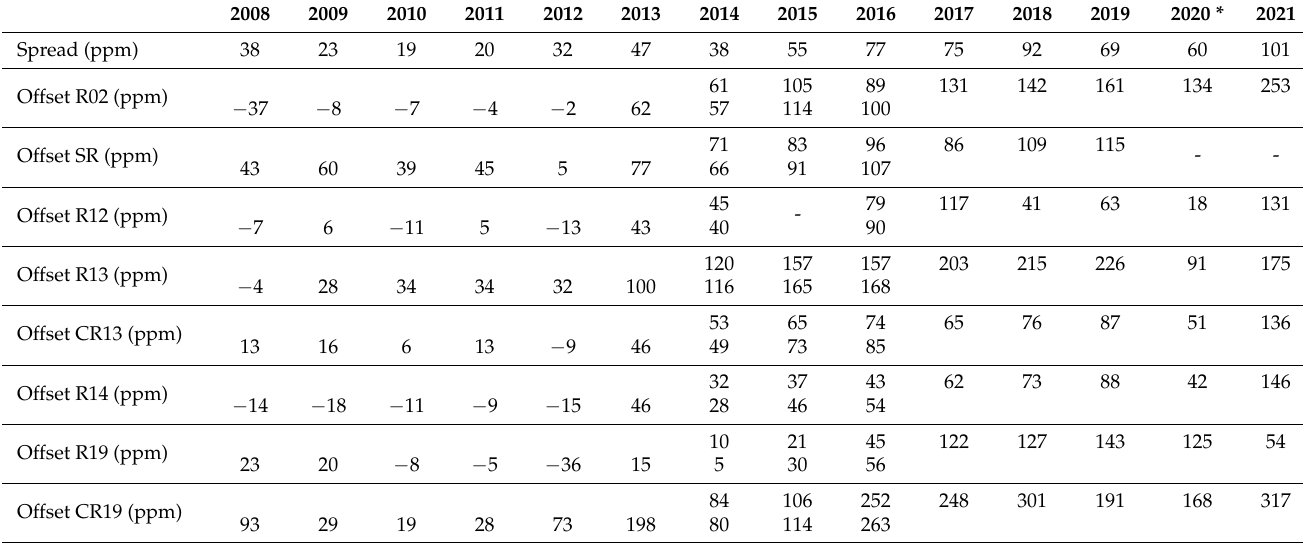
Table 3. Offset regarding the reference sensors and spread of all the measurements, considering periods of each year in August and March when the building was not being used from 2008 to 2021. From 2008 to 2016, the reference sensor is Ext (second row when both references are available). Since 2014, the reference sensor is R01 Ref (first row when both references are available).